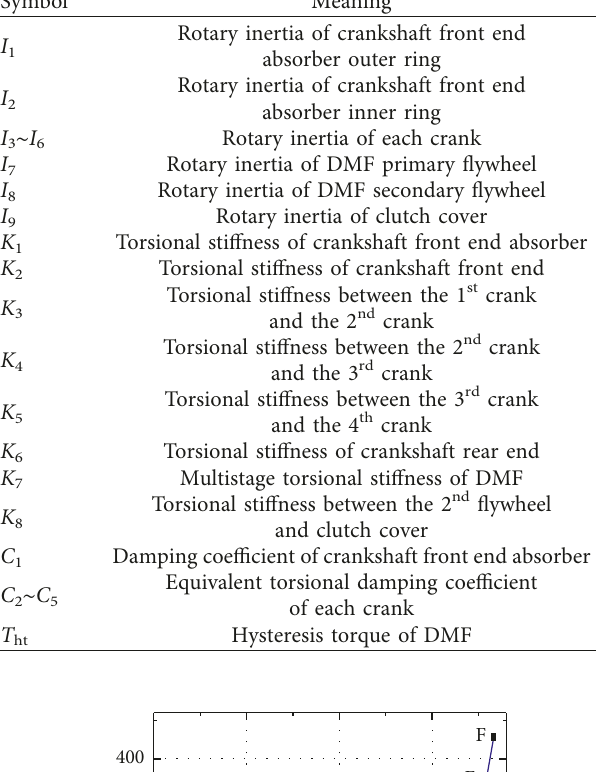
Table 1: Parameters of DMF driveline under start-up condition. Symbol